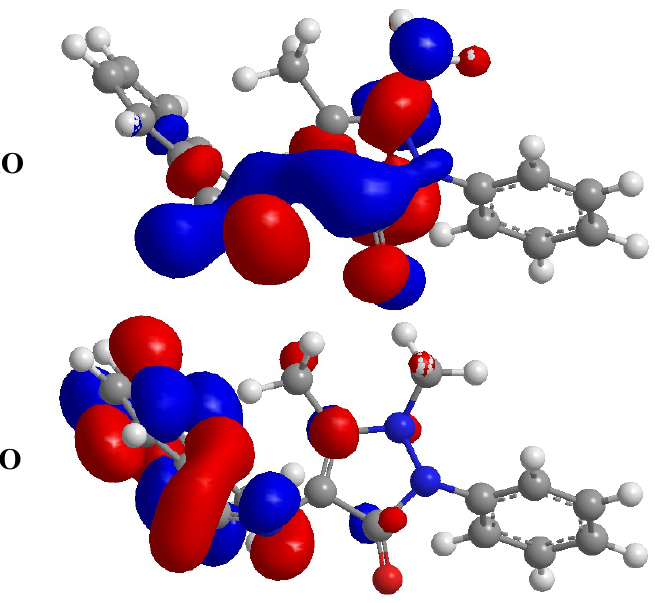
Figure 5. The HOMO and LUMO of